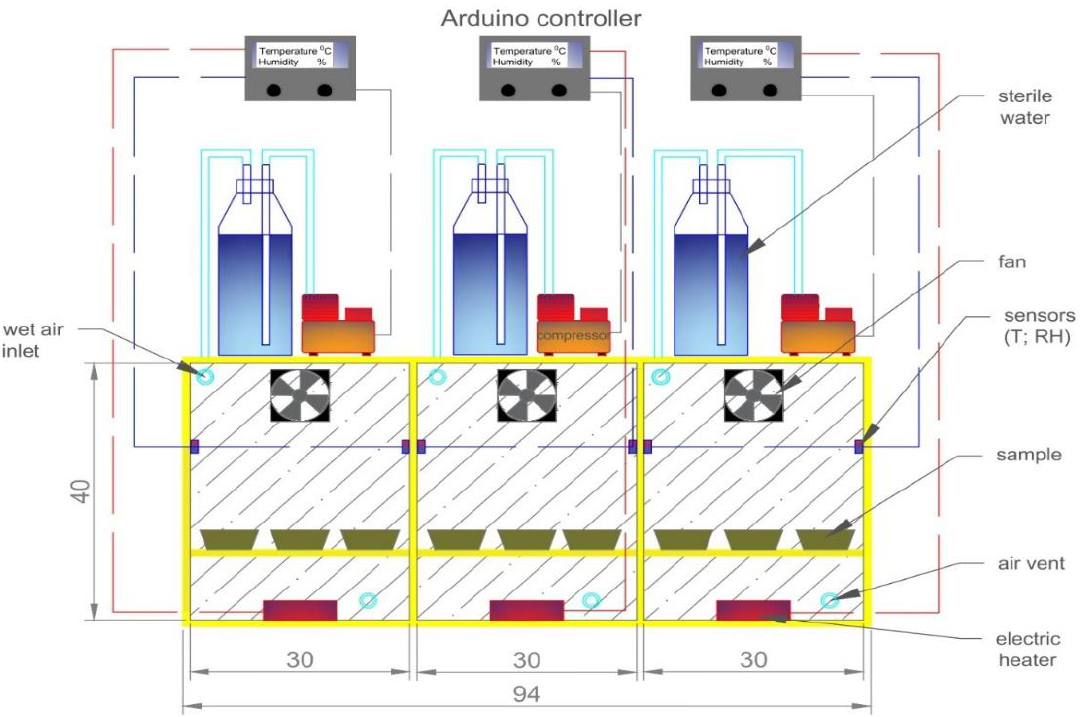
Figure 1. Diagram of the experimental installation, composed of three tray-type SSF bioreactors, with temperature and relative humidity controls.